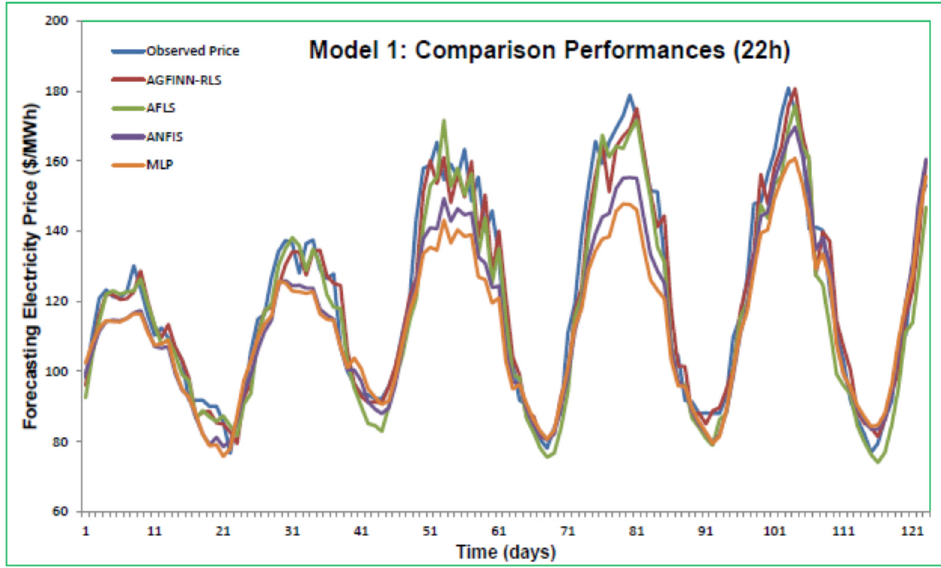
Energies 2019 , 12 , x FOR PEER REVIEW Figure 7. Prediction for electricity price at 22:00—case study 1. Figure 7. Prediction for electricity price at 22:00—case study 1.